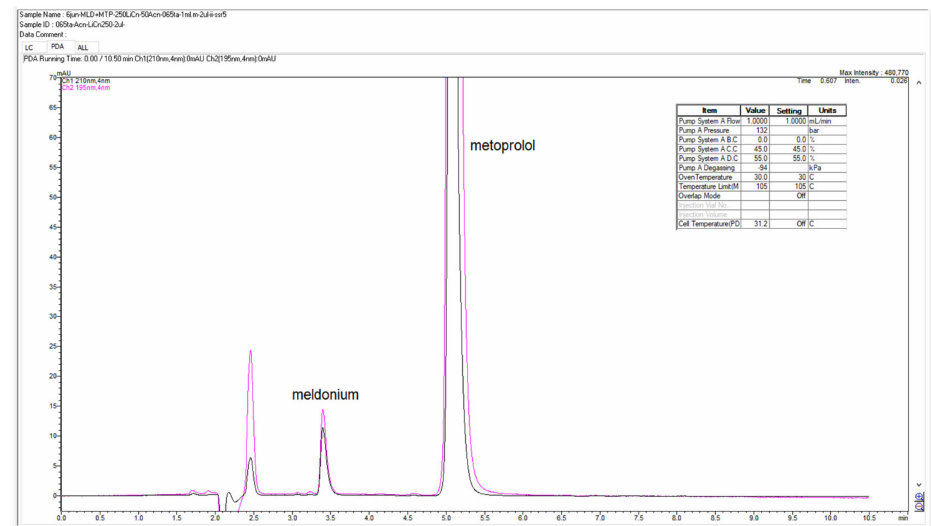
Figure 12. Chromatogram of LiChrospher 250 × 4 mm, with 55% diluted TFA and 45 %ACN at 2 comparison wavelengths, 195 nm and 210 nm. Operational and monitoring parameters presented on the table on the right.